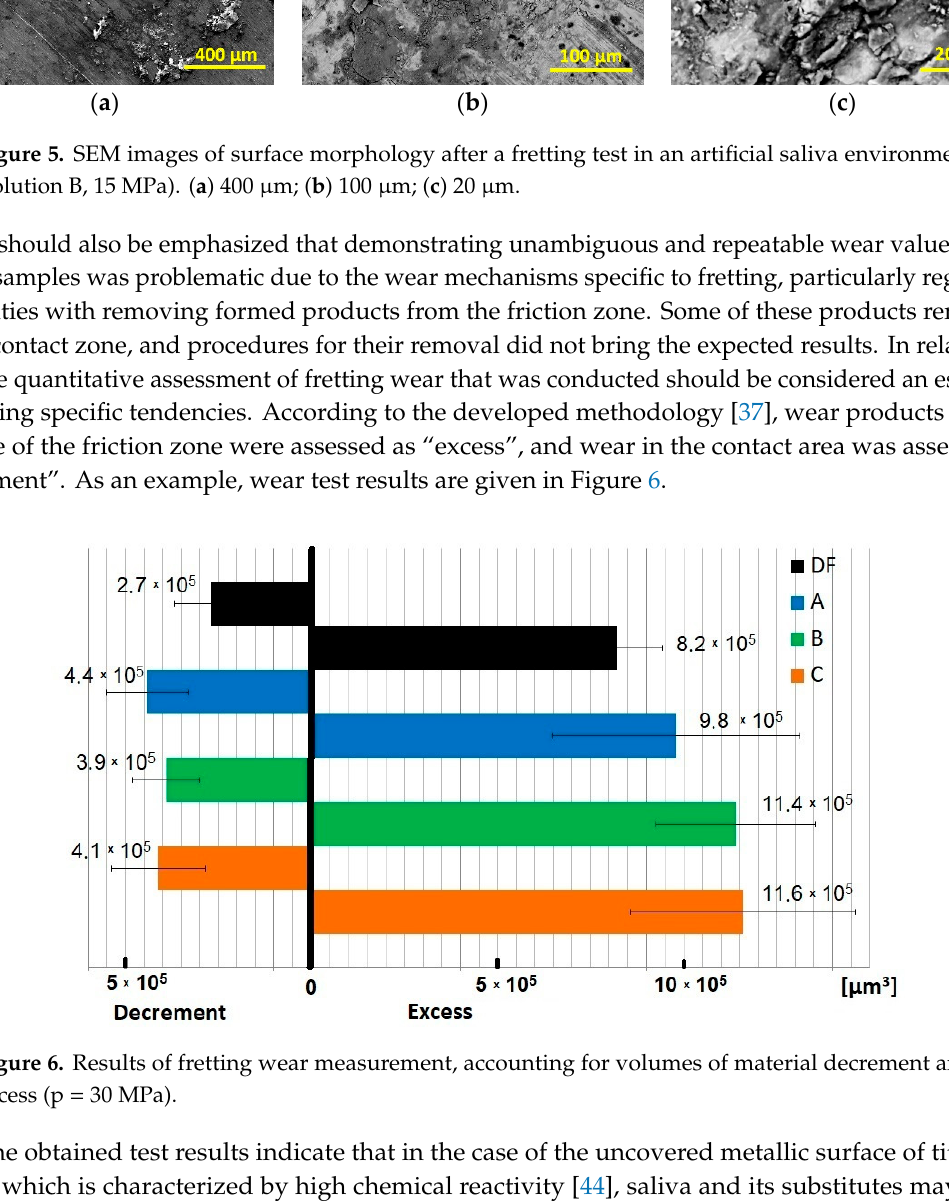
Figure 5. SEM images of surface morphology after a fretting test in an artificial saliva environment (solution B, 15 MPa). ( a ) 400 µ m; ( b ) 100 µ m; ( c ) 20 µ m.